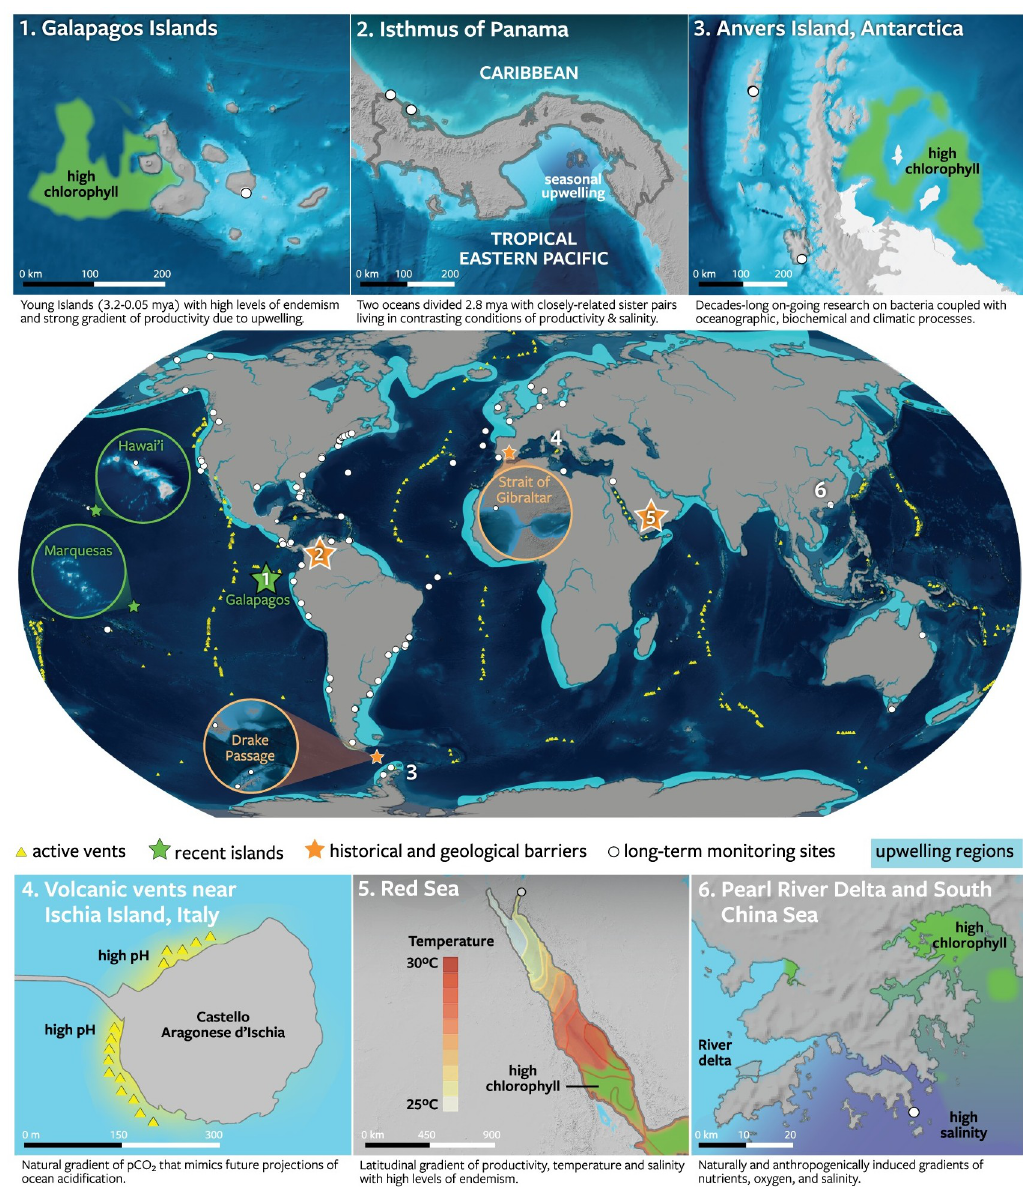
Fig 1. Examples of marine natural experiments as observatories of host–microbe interactions. Regionally focused, long-term, and taxonomically broad research programs will help fill key knowledge gaps about the nature of microbe functions and the dynamics of host–microbe interactions in changing oceans. We highlight areas of the world’s oceans where environmental gradients are well characterized, where the taxonomy and evolutionary history of the local host fauna and flora is already